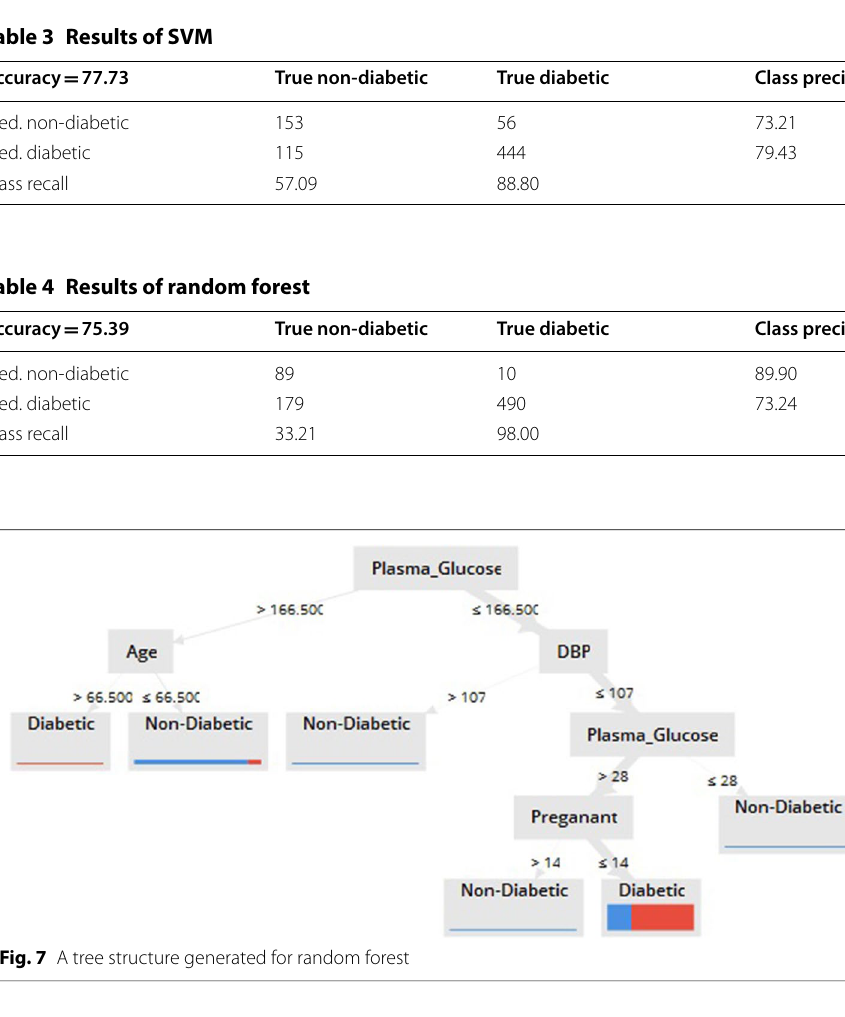
Table 5 Results of Naïve Bayesian Accuracy =